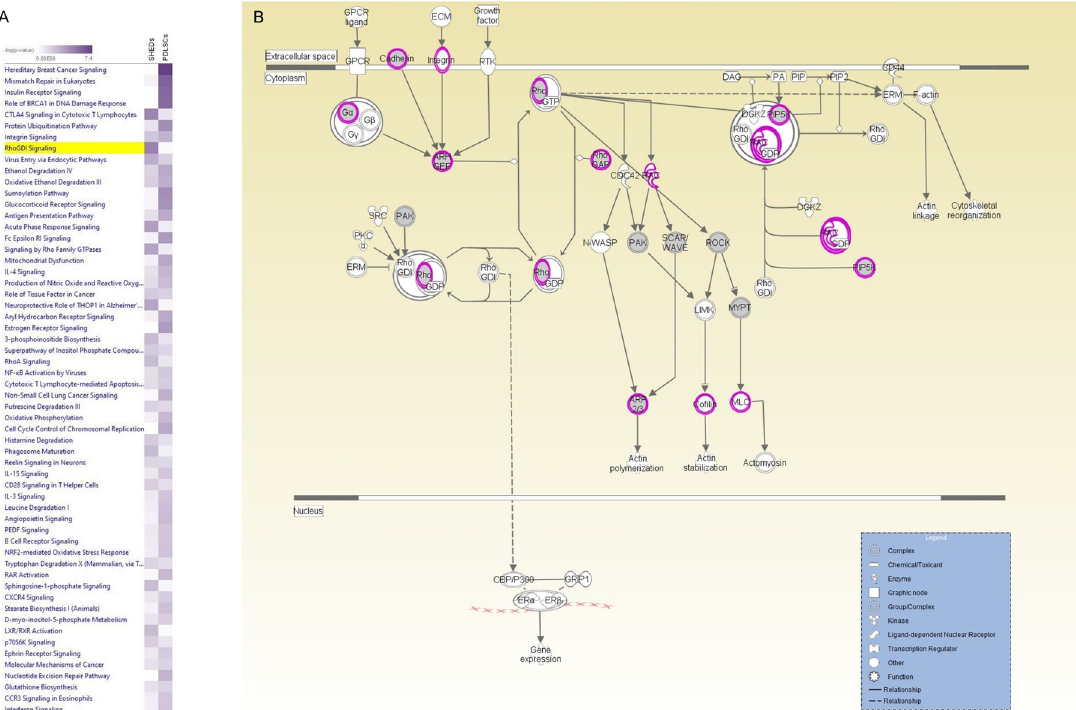
Figure 5. Comparative quantification of molecular pathway’s competence in SHED- and PDLSC-specific proteomes—IPA-mediated reconstruction of Rho-GDI signaling network. ( A ) A unified heat map created via IPA utilization, illustrating selected canonical molecular pathways likely operating, (albeit differently), in both SHED and PDLSC sub-populations. The intensity of purple color is proportional to the -log ( p value), while the decreased-color intensity denotes the fewer number of genes recognized for each of the indicated functions. ( B ) The Rho-GDI signaling pathway, as generated by IPA application. Annotated proteins from the SHED-specific proteomic list are indicated in purple circle-perimeter, while the ones from PDLSC-specific proteomic catalogue are shown in grey